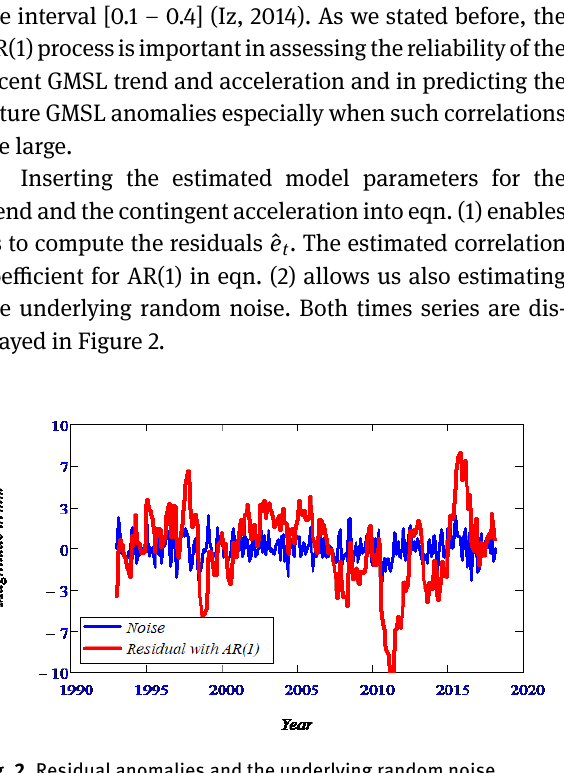
Fig. 2. Residual anomalies and the underlying random